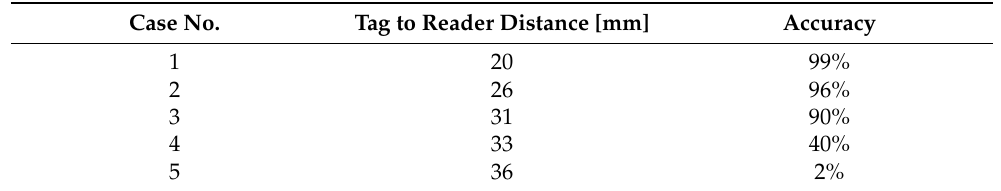
Table 4. Test cases for distance between RFID tag and reader. Case No. Tag to Reader Distance [mm] Accuracy